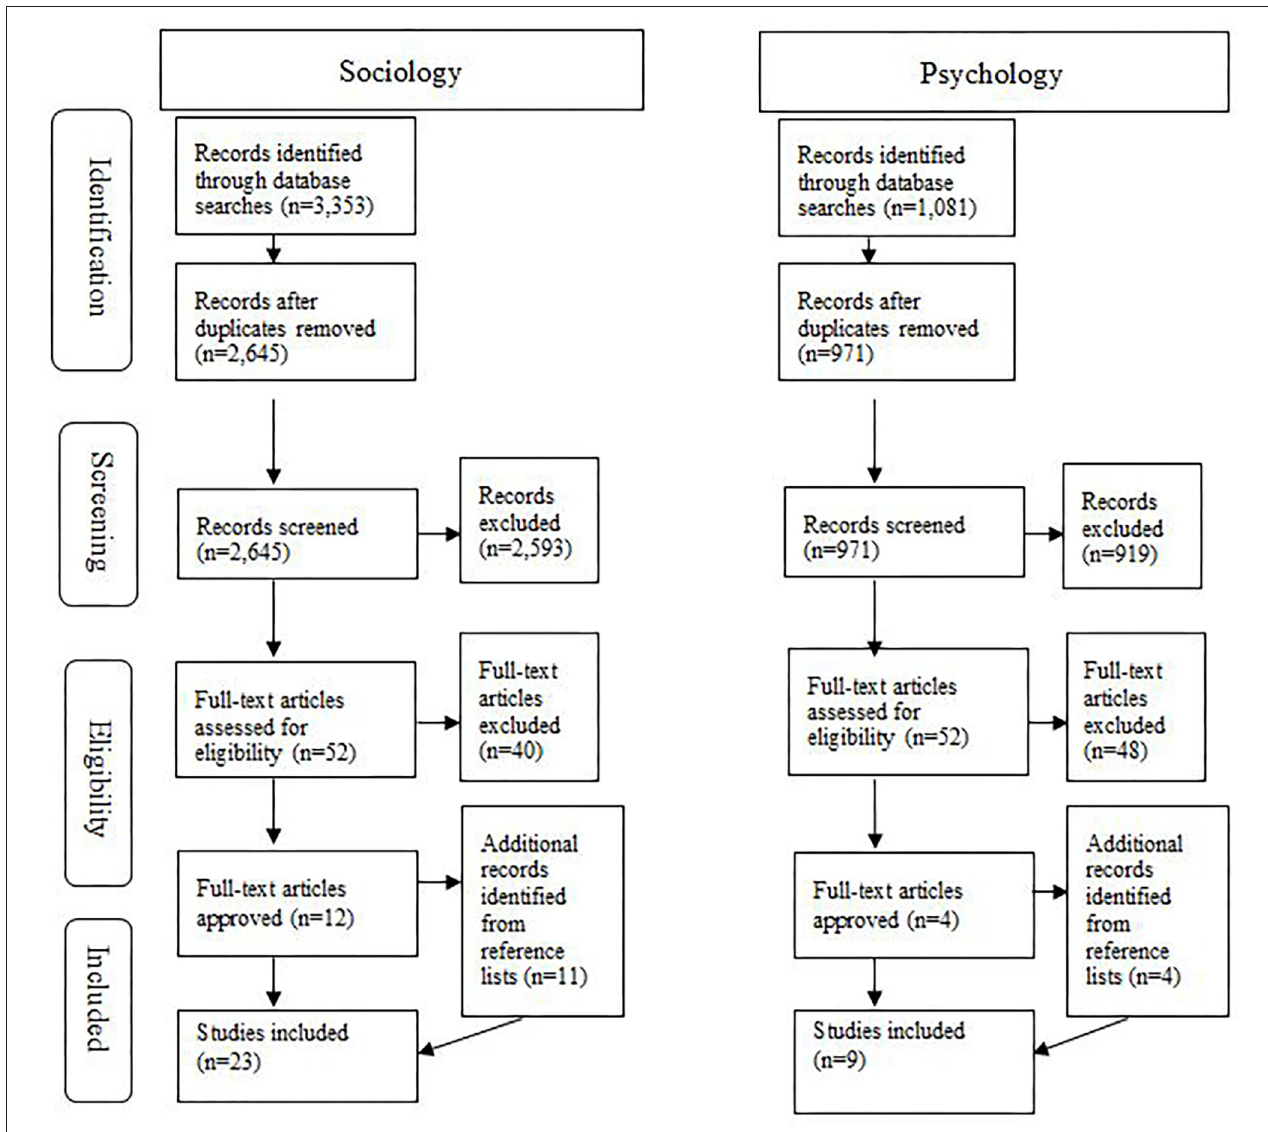
FIGURE 1 | PRISMA flow